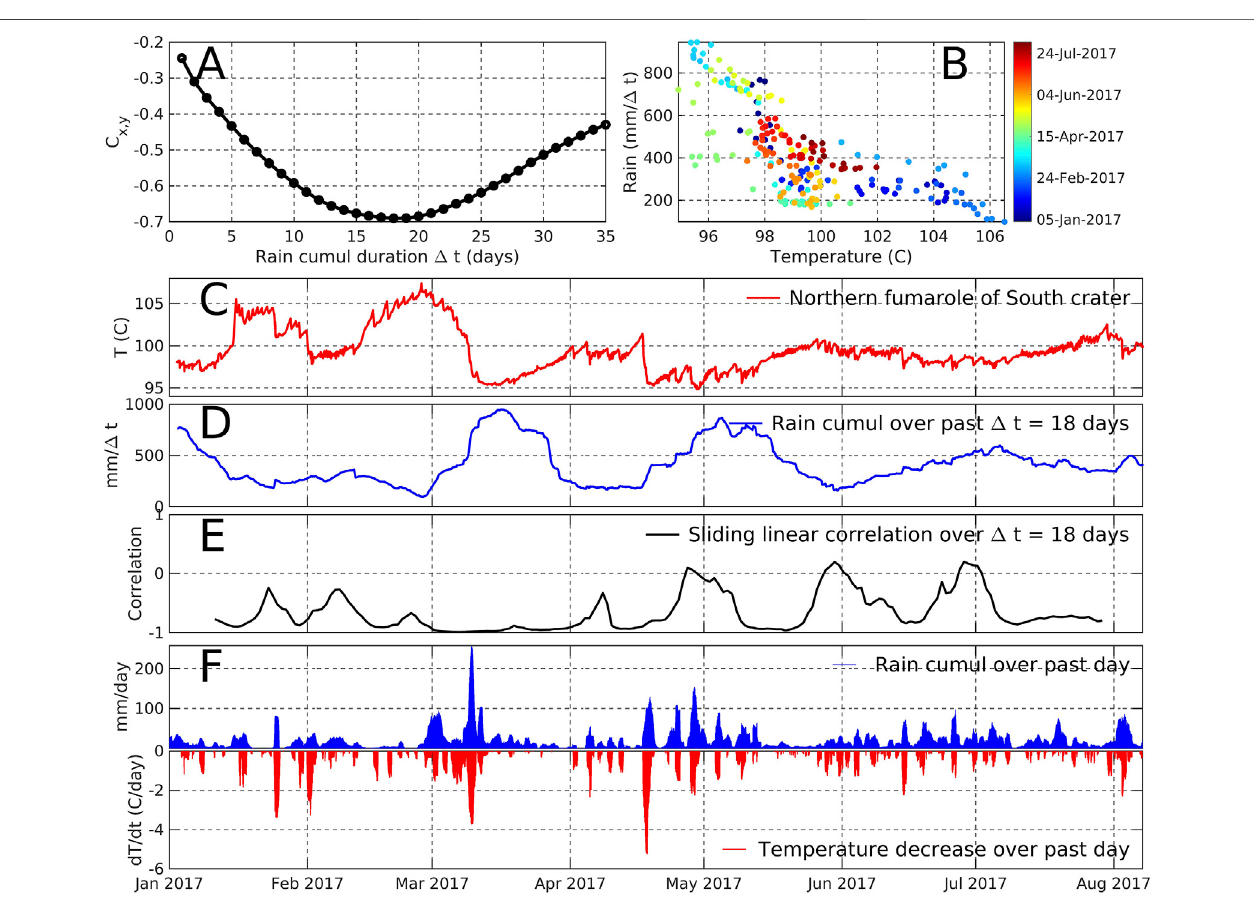
FIGURE4| Long-andshort-termcorrelationbetweenrainand temperature atNSC (A) Bestcorrelationvalueobtainedfordifferentdurationsofrainaccumulation. The best anti-correlation is for Δ t (cid:2) 18 days (Eq. 1) (B) Scatter plot of cumulated rain data for Δ t (cid:2) 18 days and NSC temperature (C) NSC temperature time series (D) Cumulated rainfor Δ t (cid:2) 18 days (E) Linear correlationcoef fi cient betweencumulated rainand NSC temperaturederived forasliding window of18 days (F) Mirrorplotof cumulated rain for Δ t (cid:2) 1 day and of 1-day temperature difference at NSC (Eq. 2) .